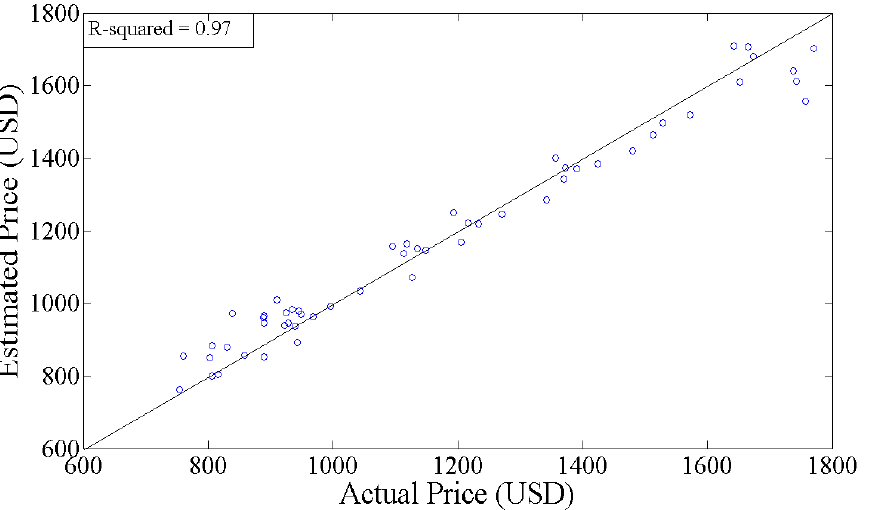
Figure 7. The gold price test data sets observed vs. predicted values are displayed in a scatter plot using an evolutionary-based NN model.